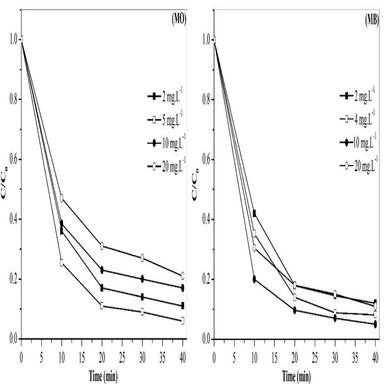
Effect of initial dye concentration on the degradation of MO and MB. Conditions: H2O2, 10 mM for MO, 12 mM for MB; pH, 3 for MO, 3.5 for MB and Catalyst, 0.06 g L1 .